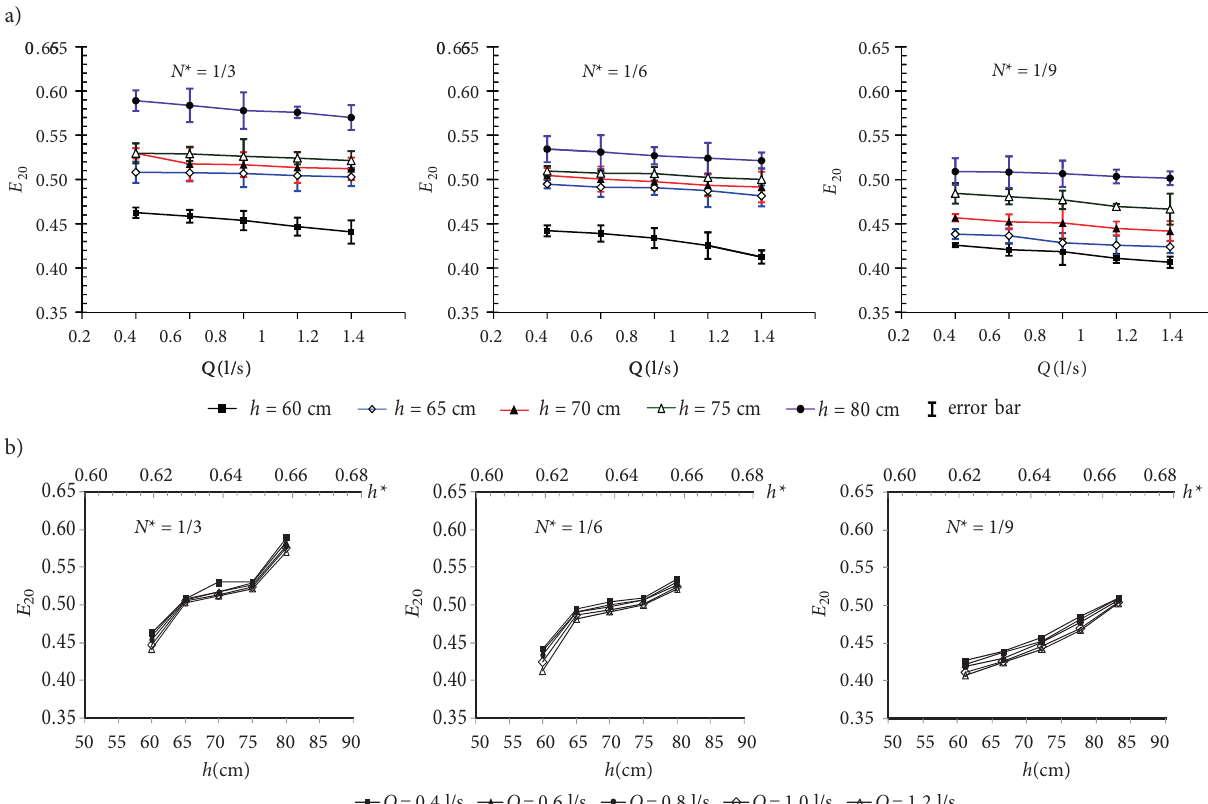
vs. Q ; (b) E vs. 20 20